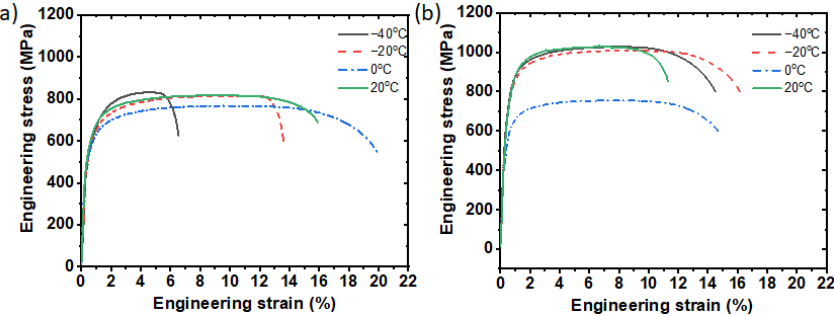
Figure 5. Engineering stress − strain curves of ( a ) DP800 and ( b ) DP1000 BM at different deformation temperatures of − 40 °C . to 20 °C.